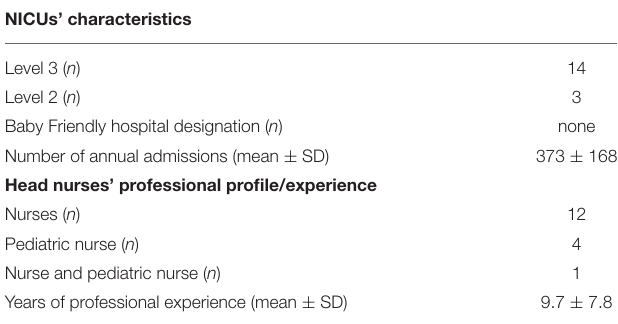
TABLE 2 | Basic characteristics of the enrolled NICUs and of the respondents.